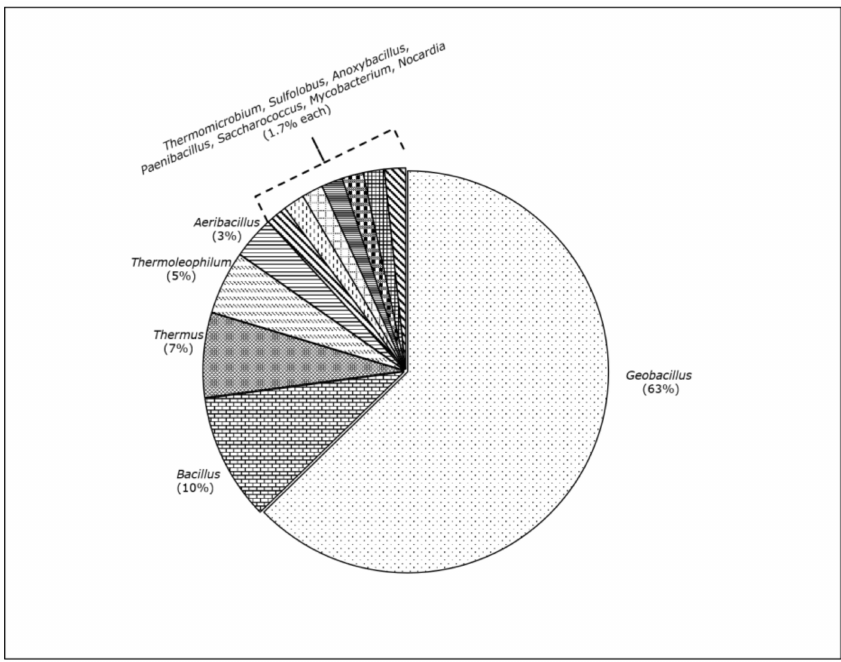
Figure 2. Distribution of genera of the 59 thermophilic strains degrading petroleum hydrocarbons summarized in Table